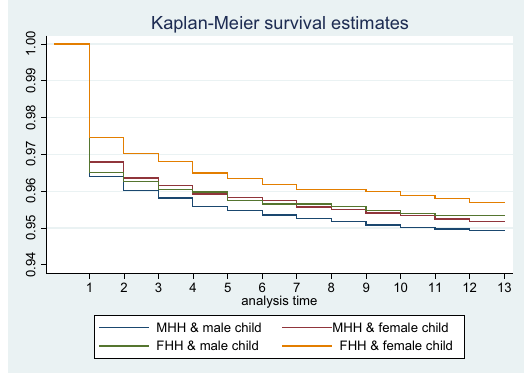
Figure 2 Survival pattern according to sex of the child in MHH and FHH, NFHS-3 (2005-06), India risk of infant death while increase in average number of children born, elevated the hazard of infant